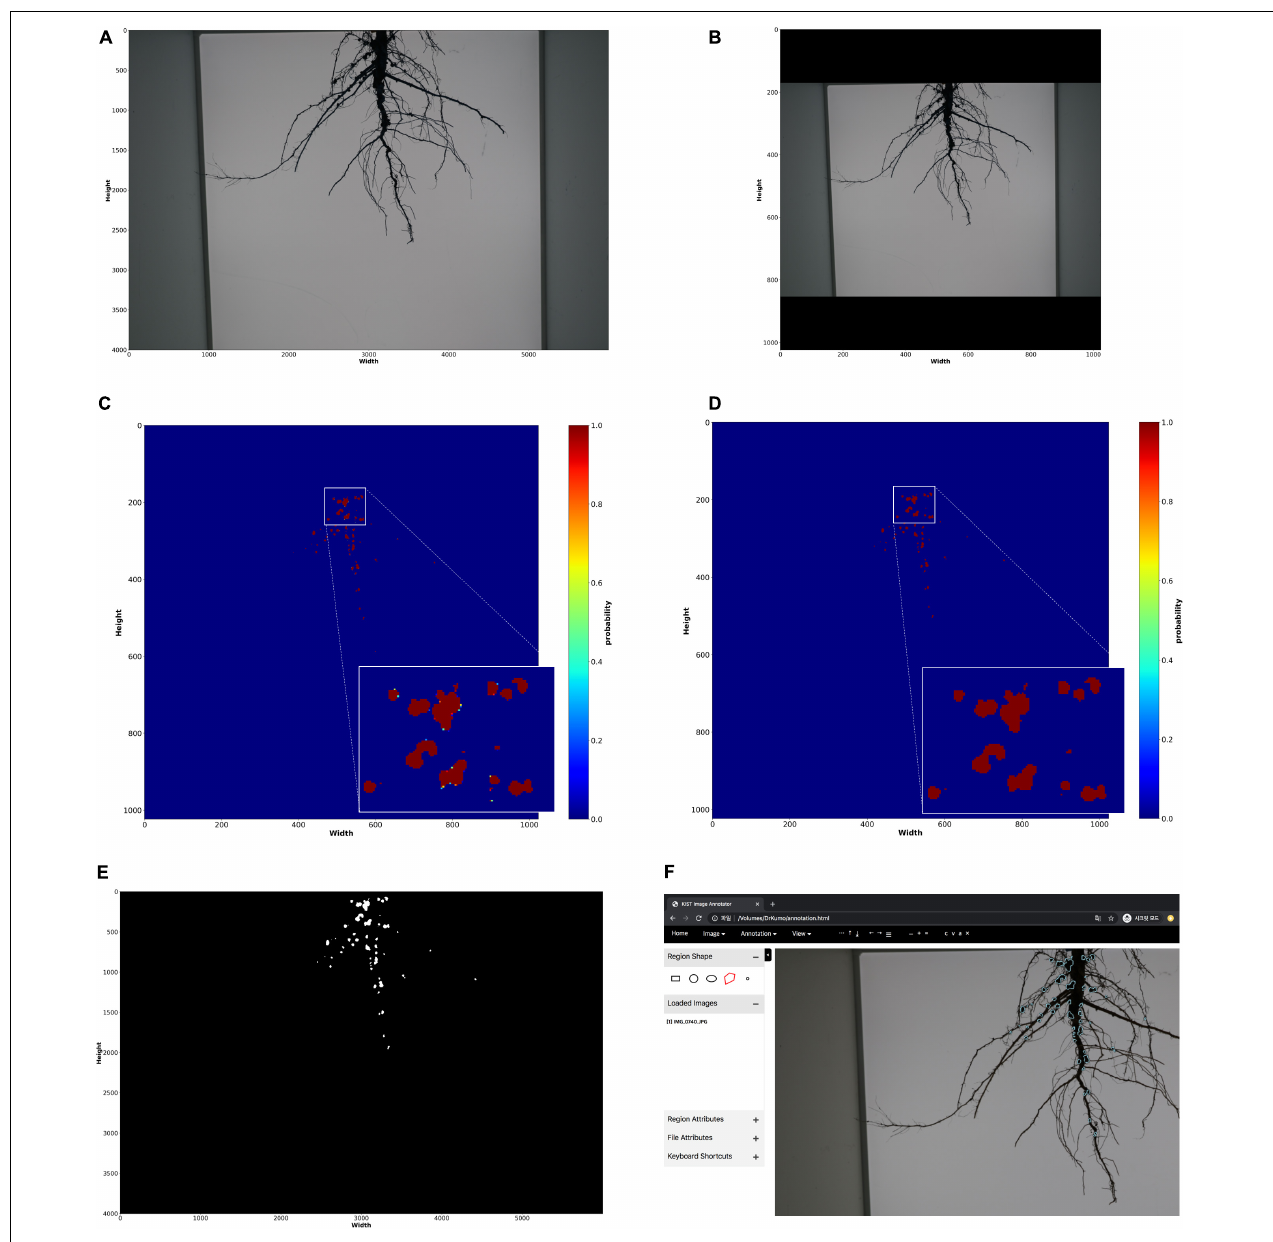
FIGURE 4 | Nodule measurement processes. (A) raw input RGB color image (6000 × 4000 dimensions) (B) pre-processed RGB color image (1024 × 1024 dimensions) (C) segmentation results; probability for each pixel (1024 × 1024 dimensions) (D) post-processing results on segmentation result (1024 × 1024 dimensions) (E) reconstruction of original size (6000 × 4000 dimensions) (F) loading nodule regions on annotation tool; the regions extracted from the final reconstructed segmentation result is displayed on the